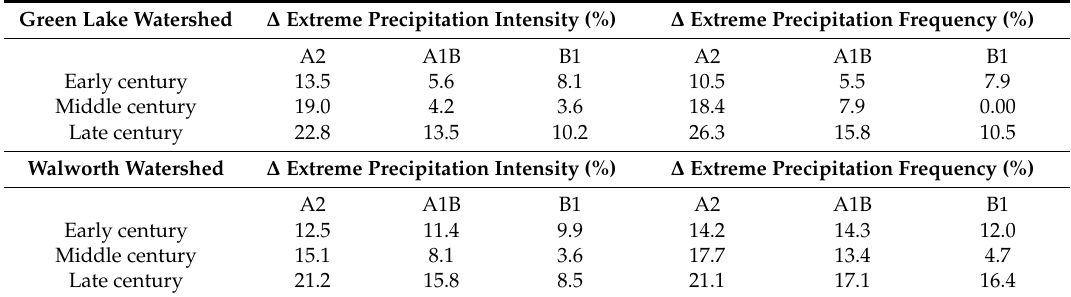
Table 4. Percent change of extreme precipitation intensity and frequency from the base period for the three future climate scenarios.